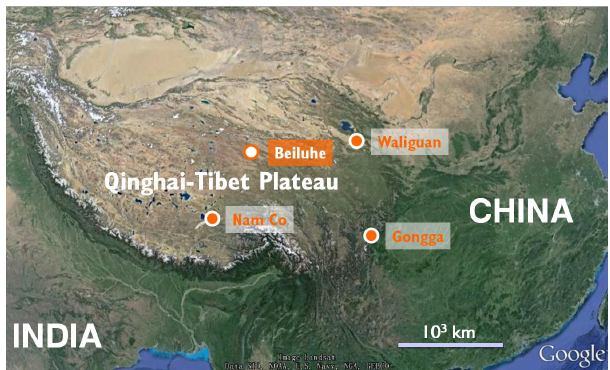
Figure 1. Locations of the Beiluhe station (4760ma.s.l., this study), Mt. Waliguan (3816ma.s.l., Fu et al., 2012), Mt. Gongga (1640ma.s.l.; Fu et al., 2008b) and Nam Co (4730ma.s.l.; Yin et al., 2015) where atmospheric Hg was